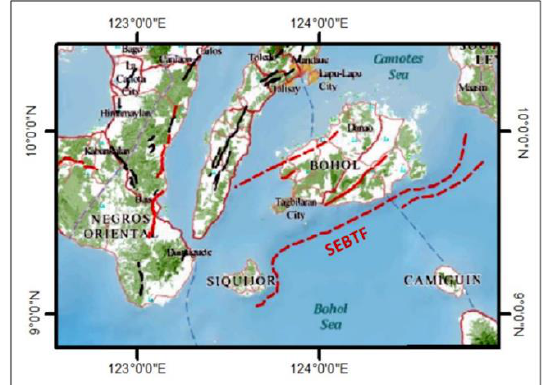
Figure 1. The South East Bohol Trench and Fault (SEBTF) The potential of satellite altimetry, tide gauge and GNSS data for VLM determination were demonstrated in several studies (Fenoglio-Marc et al. 2004, 2011, 2012; Avsar, et al. 2017; Kleinherenbrink et al. 2018; Wöppelmann and Marcos 2015; Ray et al. 2010; Nerem and Mitchum 2002; Kuo et al. 2008; Zulkifli et al. 2018; Yildiz et al. 2013) with encouraging results. VLM detection is based on the difference of the SSH from different satellite altimetry missions and TGSL that are time